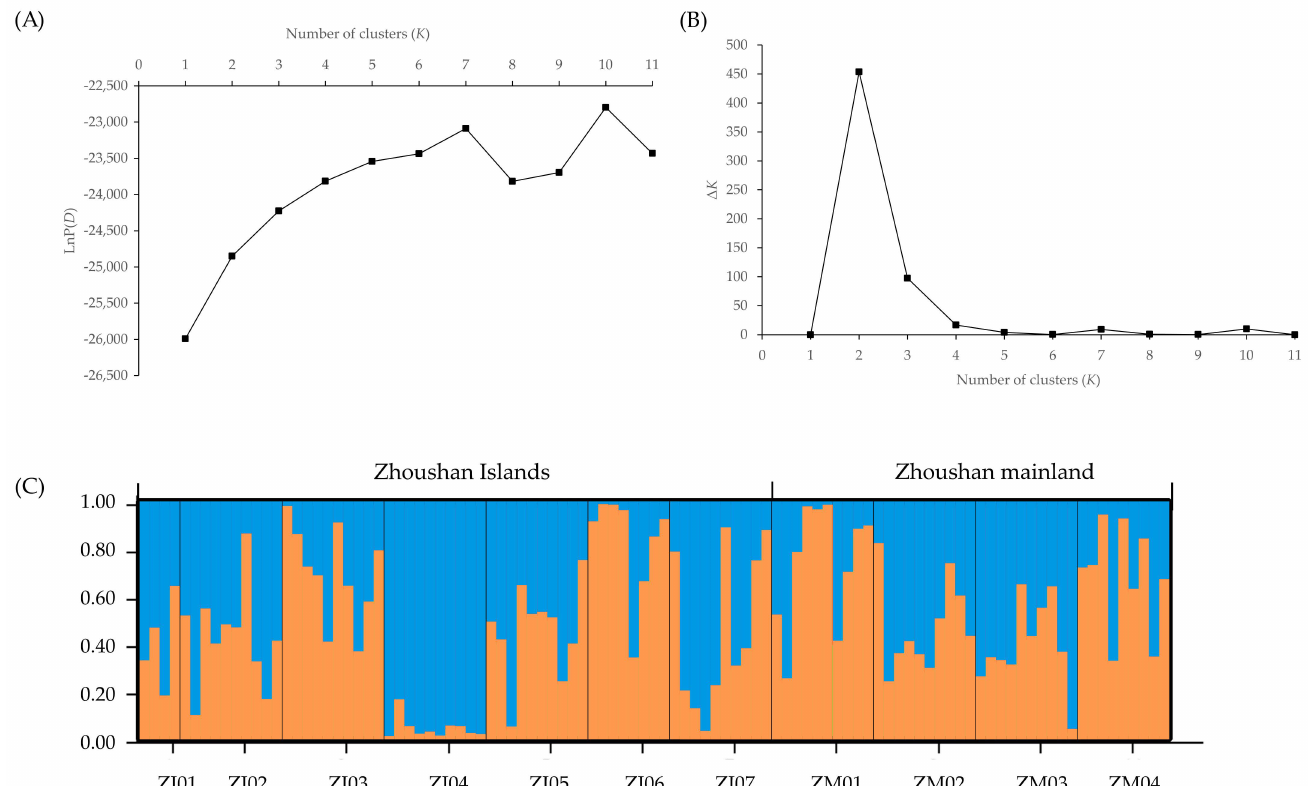
Figure 2. STRUCTURE analysis of 101 individuals (11 populations) of Hedyotis chrysotricha from the Zhoushan Archipelago (ZA) region, based on RAD-Seq-derived single nucleotide polymorphism (SNP) data. ( A ) Plots of the mean posterior probability [LnP( D )] values of each K and ( B ) the corresponding ∆ K statistics. ( C ) Histogram of the STRUCTURE analysis for the model with K = 2 (showing the highest ∆ K ). A vertical bar represents a single individual, and each color corresponds to a suggested cluster (Cluster I: blue; Cluster II: orange). The x -axis corresponds to population codes. The y -axis presents the estimated membership coefficient ( Q ) for each individual in the two